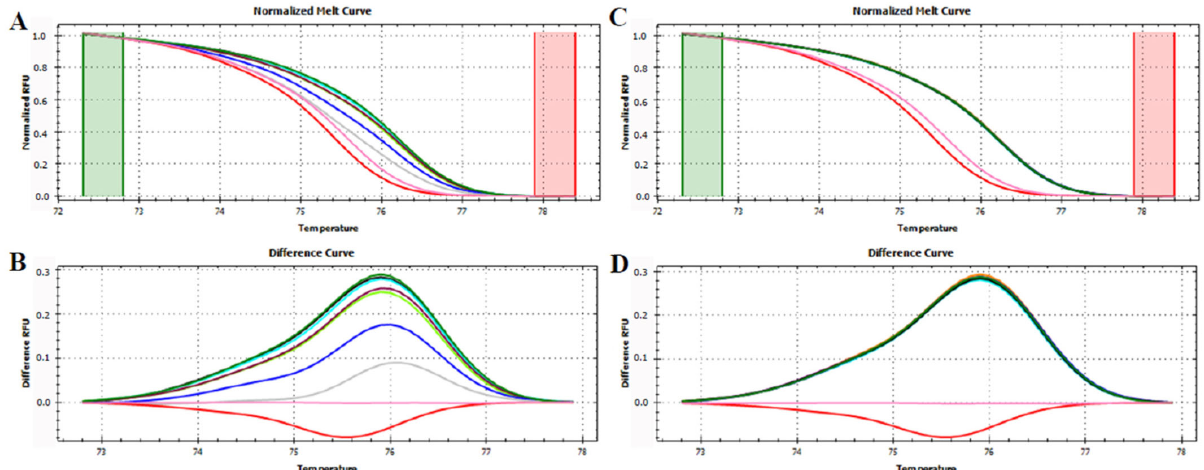
Figure 6. Normalized melt curve ( A , C ) and difference curve ( B , D ) of HRMA of P6 loop of trnL (UAA) intron on apple and kiwi mixed juices. ( A , B ) Apple fruit: red, kiwi fruit: green, apple/kiwi juices 99.5%/0.5%: grey, 99%/1%: blue, 95%/5%: purple, 90%/10%: light green, 75%/25%: light blue and 50%/50%: black. Reference cluster is pear fruit: pink. ( C , D ) Apple fruit: red, kiwi fruit: green, apple/kiwi juices 50%/50%: black, 25%/75%: purple, 10%/90%: blue, 5%/95%: orange, 1%/99%: light blue and 0.5%/99.5%: light green. Reference cluster is pear fruit: pink. The HRMA has been carried out on three independent replicates of each sample and the most representative curve of each sample is reported in the graph.